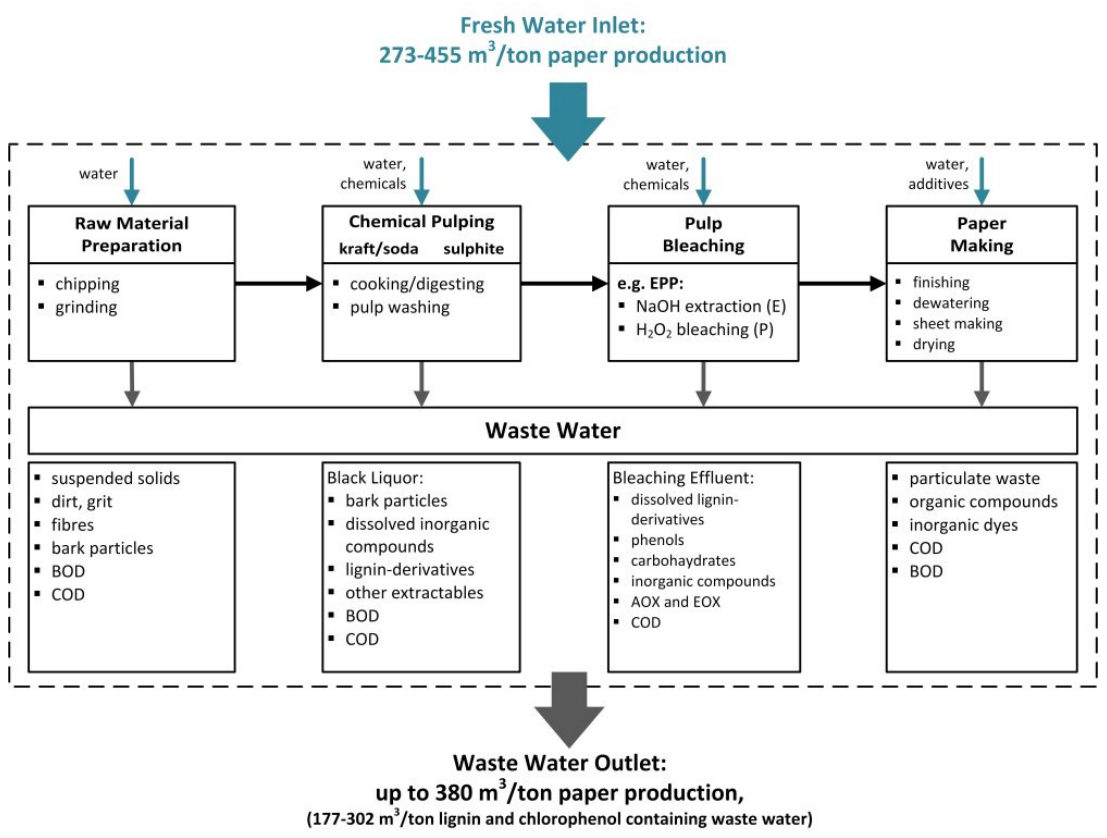
Figure 1. Schematic illustration of a paper production process (modified from [3,5,6,13,14]). AOX: absorbable organic halogens; BOD: biological oxygen demand; COD: chemical oxygen demand; EOX: extractable organic